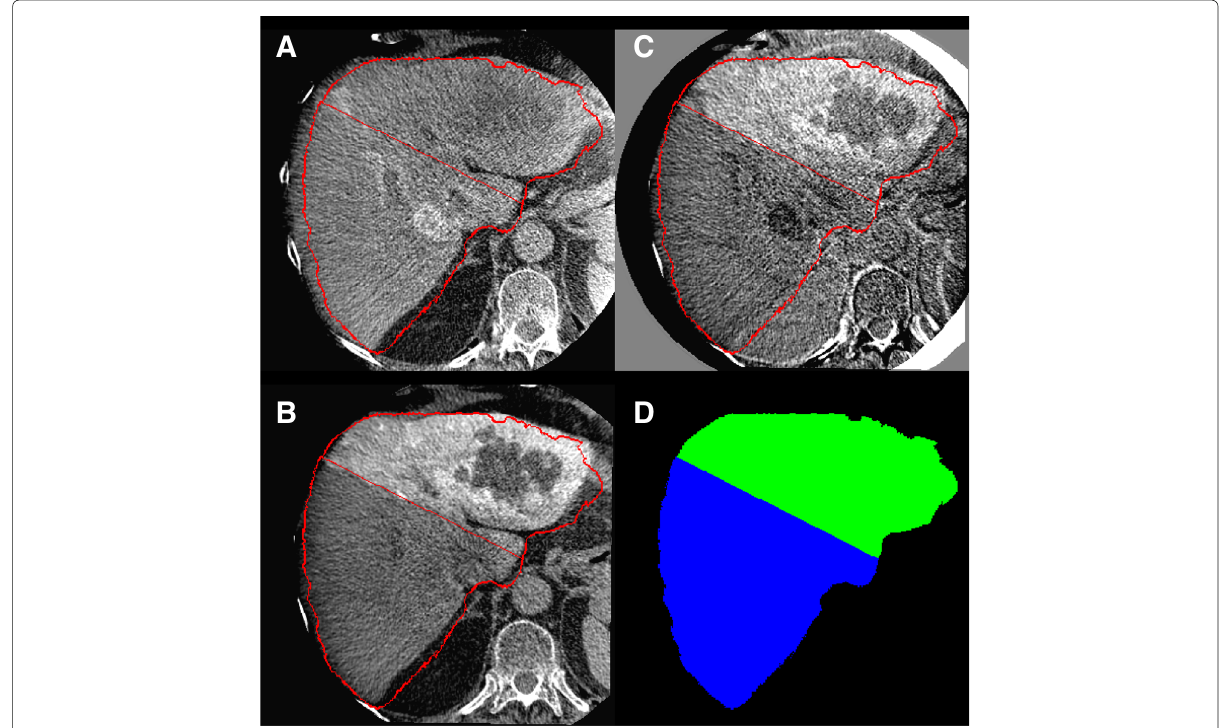
Fig. 5 Perfusion territory segmentation (patient ID BI01 from training set in our database): a , b CBCTs with late contrast enhancement for the right and left liver perfusion territory, respectively, c difference between two CBCTs, d LPT segmentation result (right lobe, blue; left lobe,